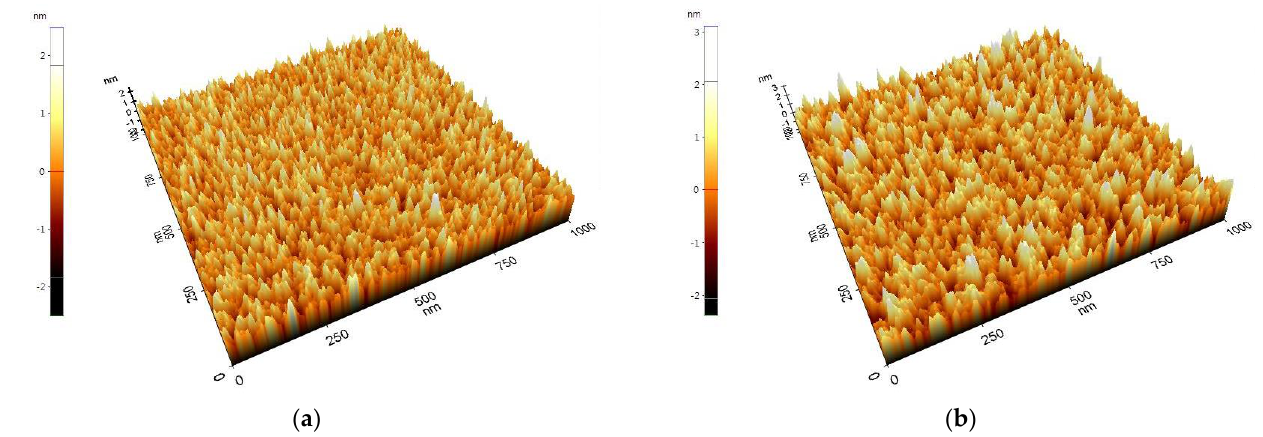
Figure 3. Atomic force microscope images of the a-SiC surfaces: ( a ) root-mean-square roughness ( Rq ) of the 100 nm-thick film was 0.481 nm; ( b ) Rq of the 300 nm-thick film was 0.628 nm. The XRR measurement results are shown in Figure 4. For the Al film, a mass density of 2.70 g/cm 3 was obtained for a film thickness of 100.5 nm and roughness of 3.542 nm in the simulation. This density value is practically the same as the literature value for bulk. For the 100 nm- and 300 nm-thick a-SiC films, density values of 1.86 g/cm 3 and 1.89 g/cm 3 were obtained, respectively. The film thickness and roughness values used in the simulation were 98.4 nm and 0.552 nm for the 100 nm a-SiC, respectively, and 306.2 nm and 0.743 nm for the 300 nm, respectively.